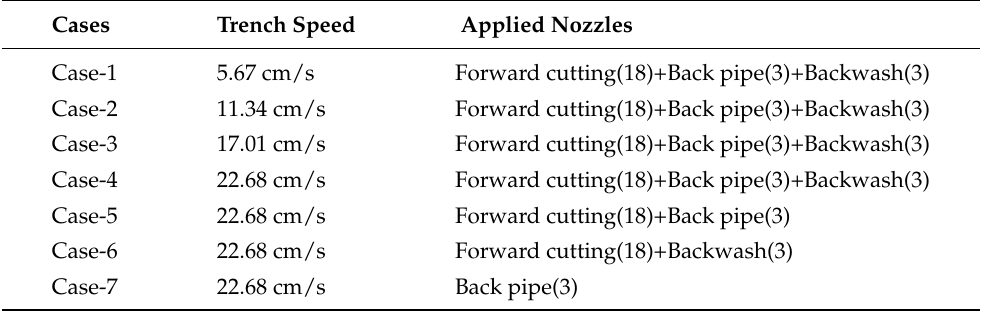
Table 5. Seven different cases in the ground field test.